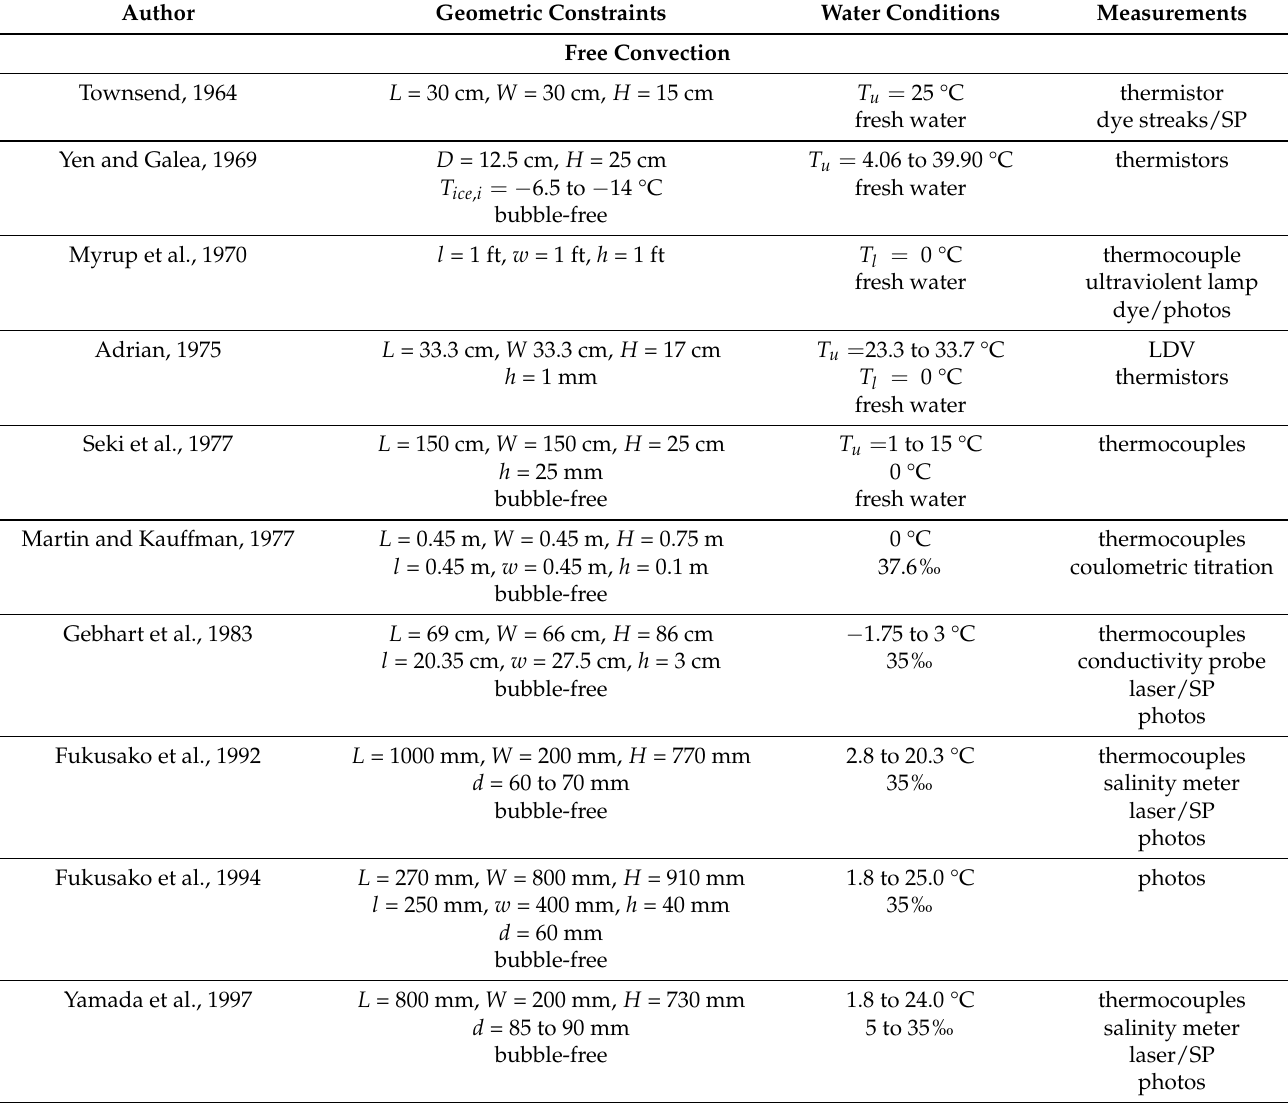
Table A1. Experiments focused on flow patterns and melting above horizontal ice in free